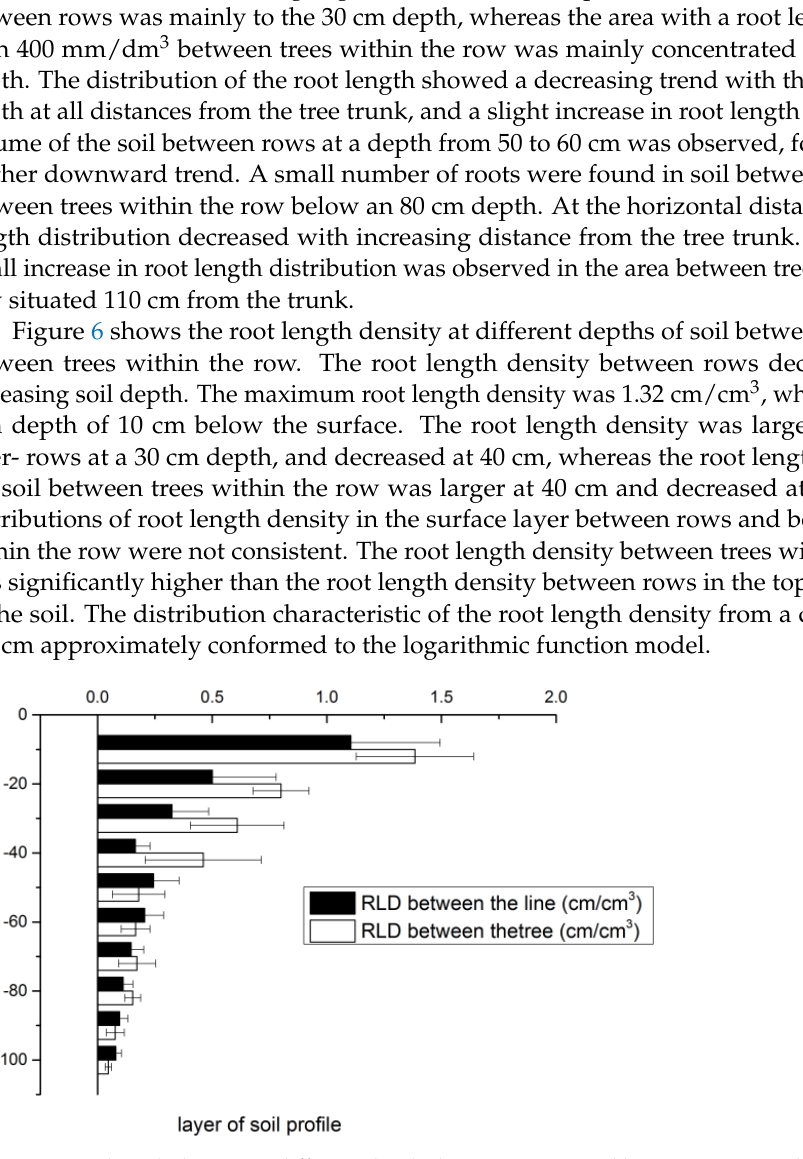
Figure 6. Root length density at different depths between rows and between trees within the row for A2 in October 2016. The error bars represent the respective standard errors for N = 8.